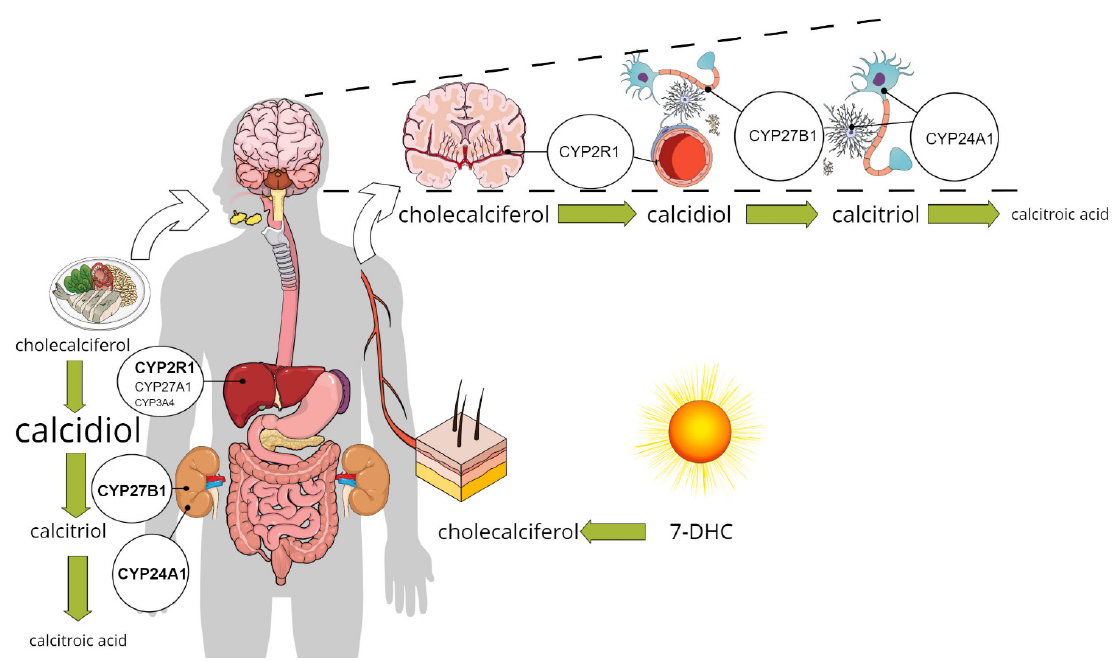
Figure 1. The classical and the alternative pathway for calcitriol synthesis: enzymes involved in calcitriol synthesis are expressed in pericytes, glial cells, and neurons in addition to the liver and kidney, pointing to the possible role for the local production in vitamin D signalling.